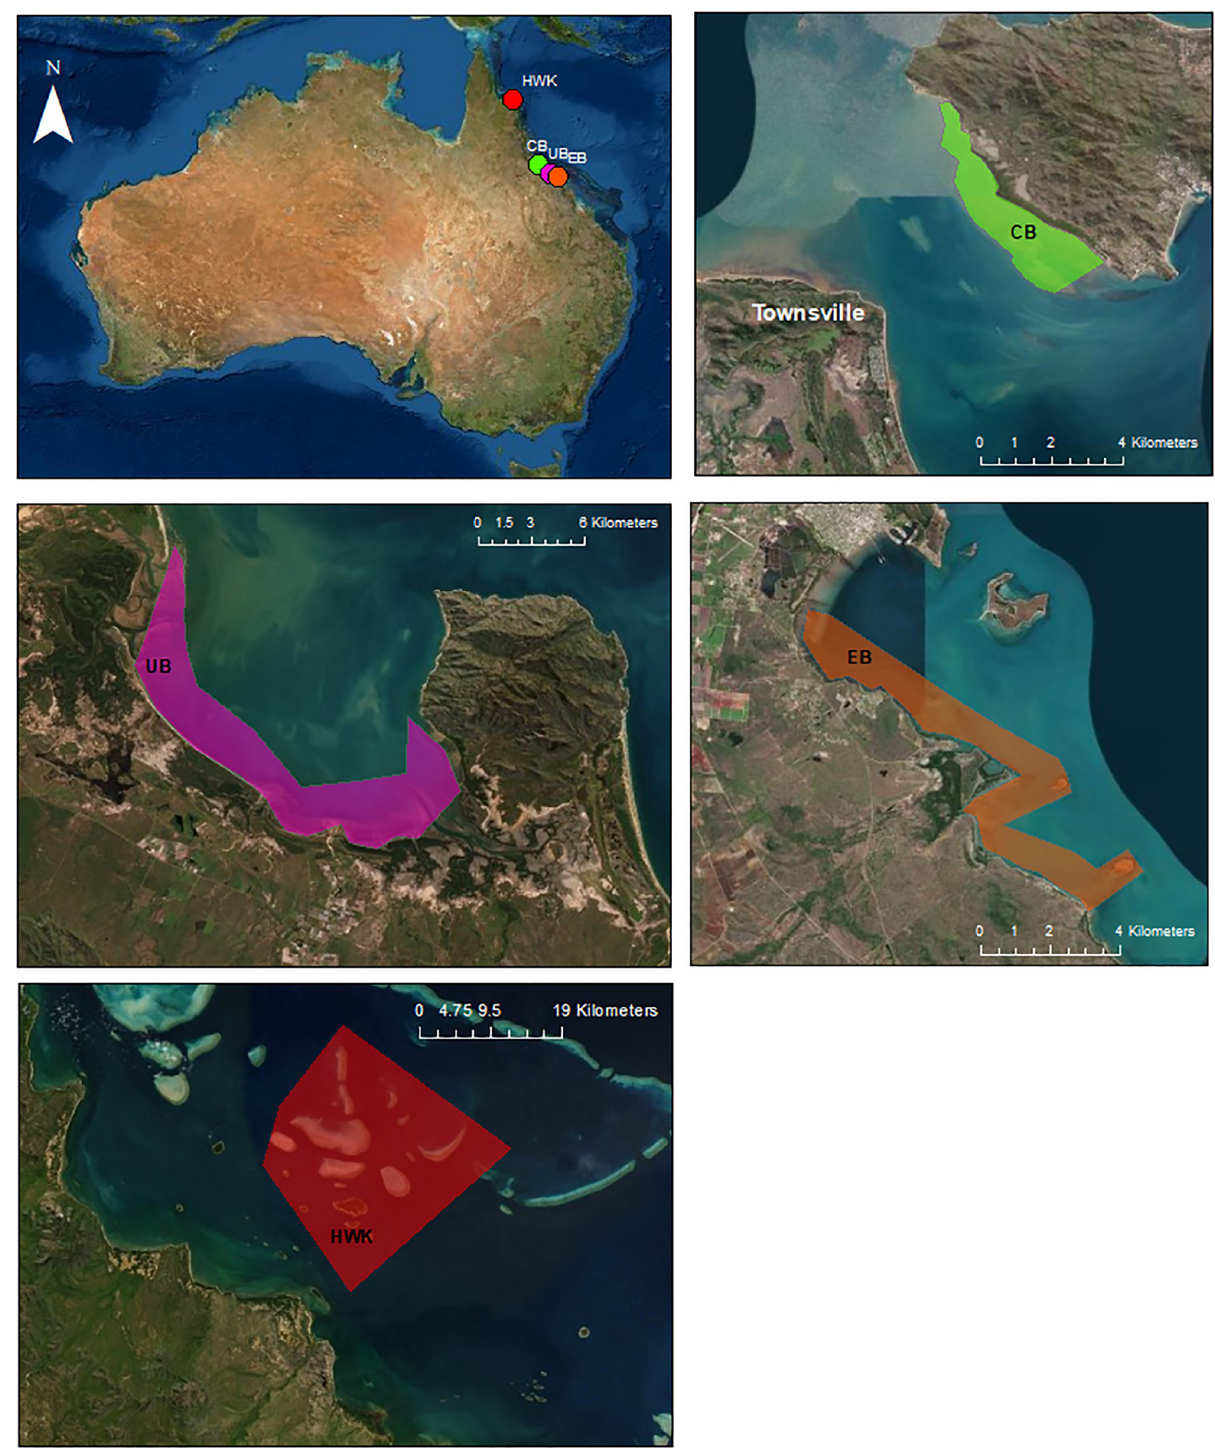
Fig 1. Overview of all study sites sampled. Map of three study areas (Cockle Bay (CB), Upstart Bay (UB) and Edgecumbe Bay (EB)) where preferred green turtle seagrass forage was sampled, and the offshore site from which data was also analysed (Howick Island Group, HWK). Each site is colour coordinated between the national overview and localised maps. Areas highlighted in colour define local green turtle foraging ranges. The areas highlighted with white and black depict seagrass sampling locations at each study site. The World imagery applied as the base map in this figure is attributed to Esri and modifications were conducted using ArcMap (version 10.7.1, Esri. ArcGIS and ArcMap, California, USA). and is permitted for use as per Esri terms of service and the DMCA (Digital Millennium Copyright